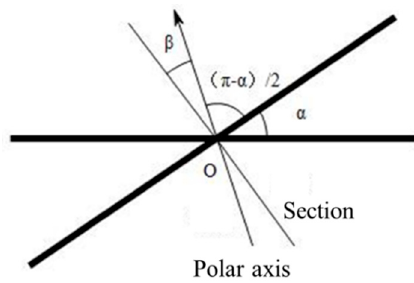
Figure 2. Diagram of two metal fibers in polar coordinates ( α and β represent the fiber angle and polar angle, respectively).